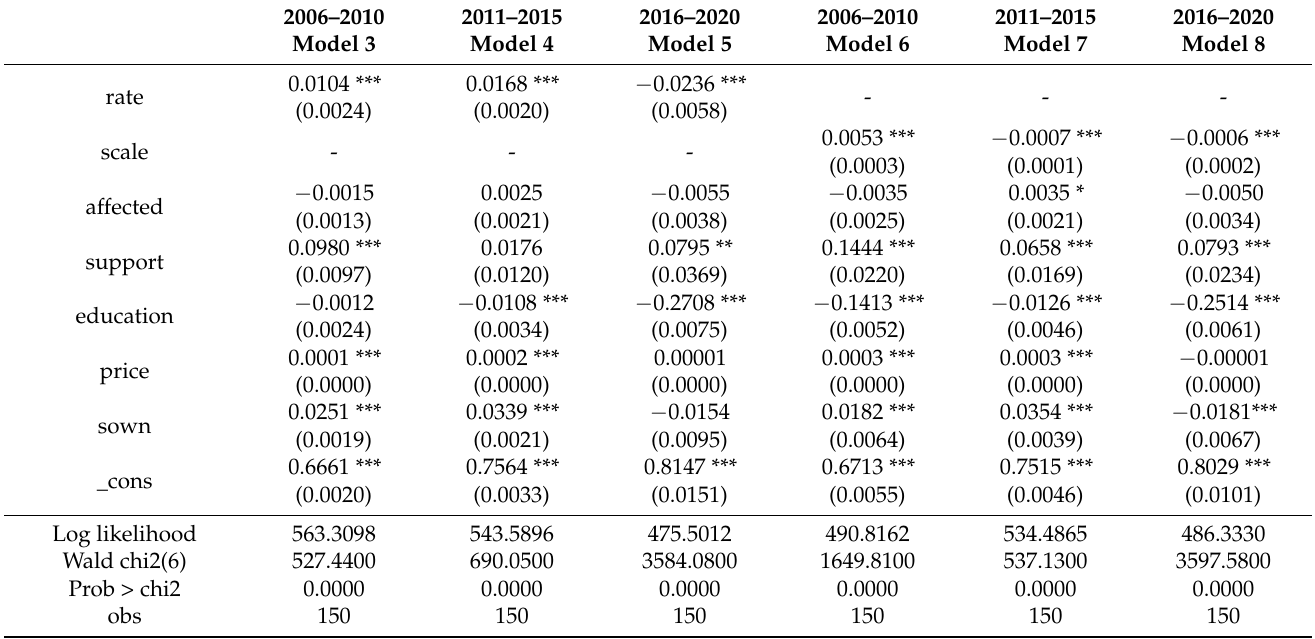
Table 4. Empirical analysis results of the impact of the rural land transfer market on agricultural technical efficiency in different